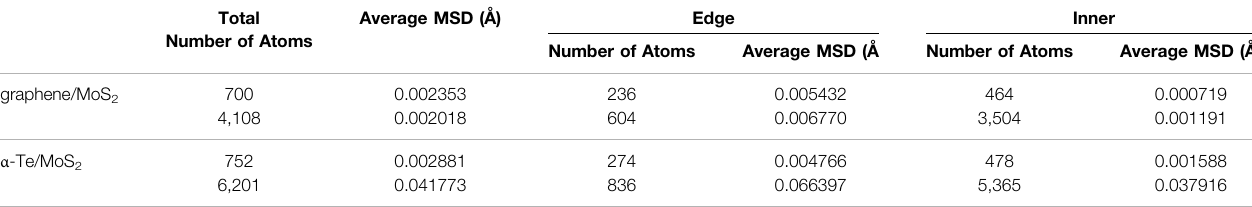
TABLE 3 | Average root-mean-square displacement of atoms of rectangular sliders during